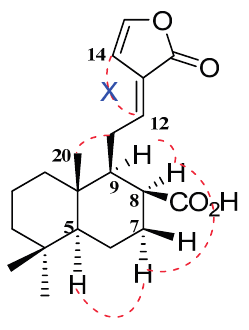
Figure 3. Key NOESY correlations of compound 3